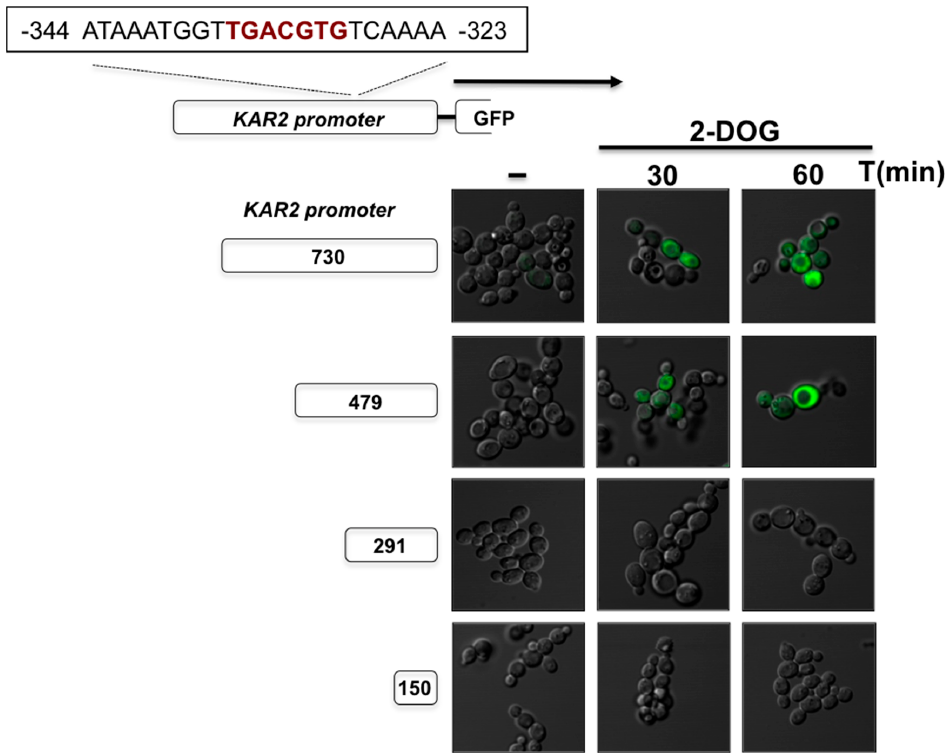
Figure 7. Detection of K. lactis KAR2 promoter activity upon ER stress. The putative KlKAR2 promoter (730 nucleotides of the upstream start codon region) and the indicated serial deletions fragments were fused to the GFP reporter gene. Constructions were cloned in an episomal multicopy K. lactis plasmid and used to transfect wild type cells. Cells were grown in YPD until 0.5 OD 600 and treated with 2-DOG for the indicated times. Cells were visualized under epi-fluorescence microscopy and photographed.